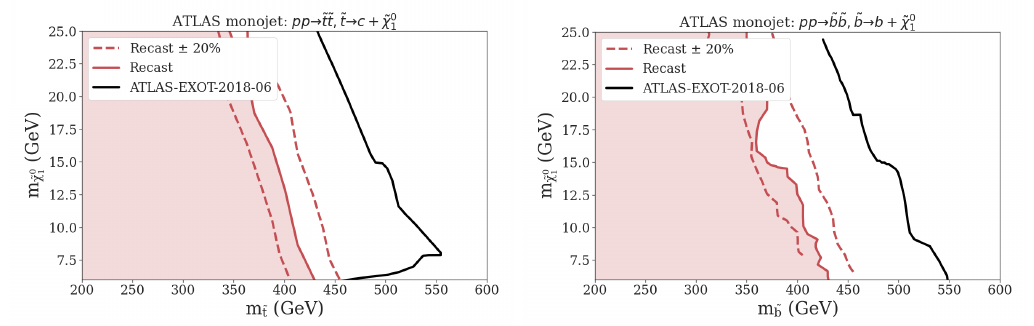
Figure 21 . Validation of the mono-jet ATLAS search [57] implemented using CheckMATE 2 . The solid black line shows the official exclusion curve, while the solid red curve shows the one obtained through recasting. The left panel shows the results obtained for the compressed stop simplified model, while the right panel displays the results for the compressed sbottom